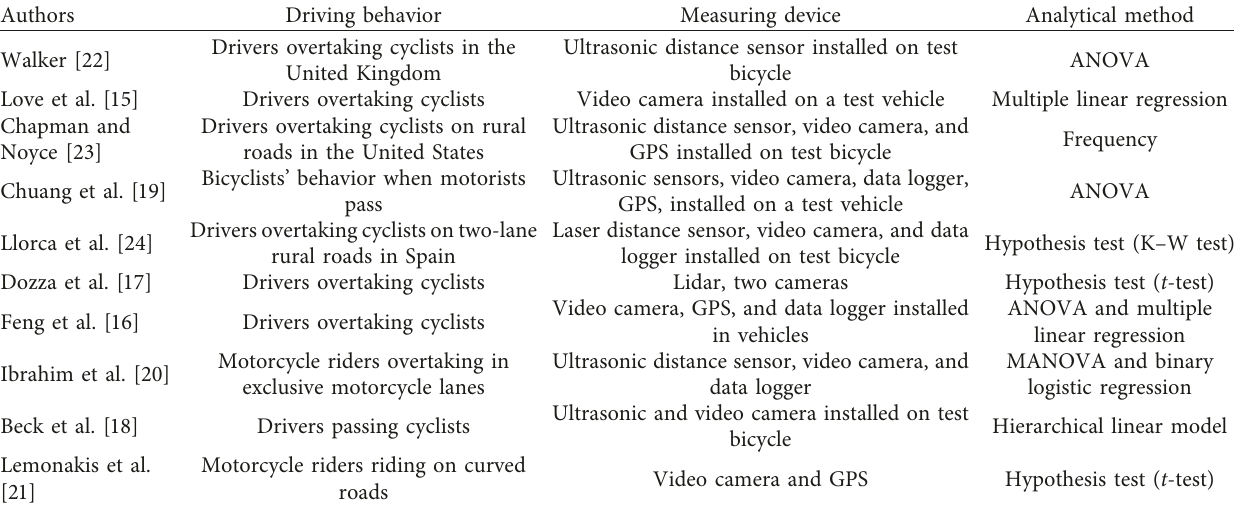
Table 1: Summary of previous instrumented vehicle studies on driving